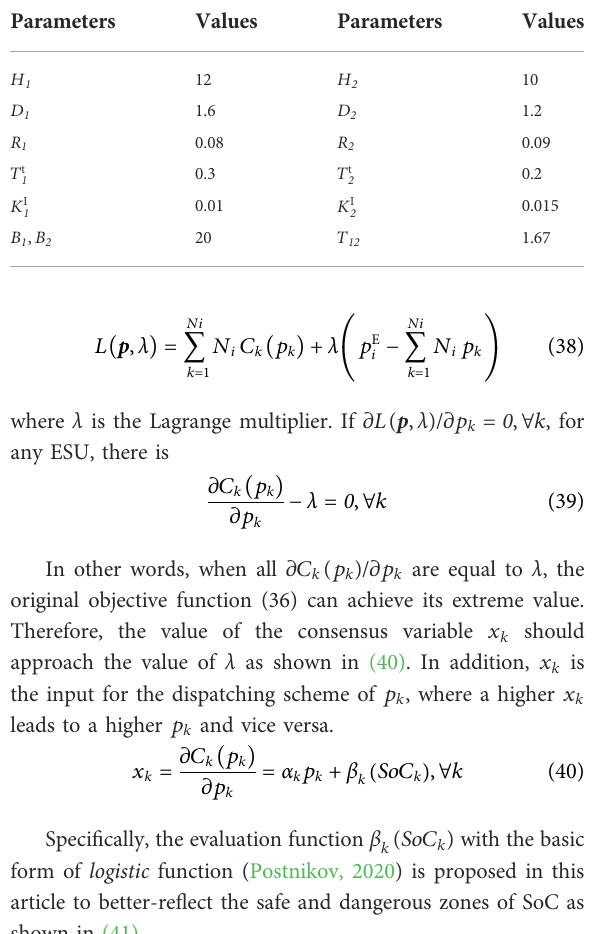
TABLE 1 Parameters of the system frequency regulation model in